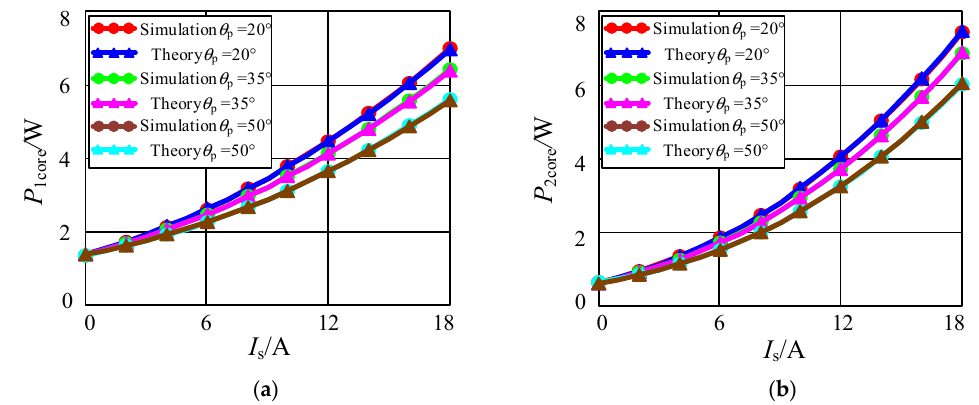
Figure 11. The core losses of the disk core obtained by theoretical calculation and simulation under different current phase differences. ( a ) Transmitter core; ( b ) Receiver core.